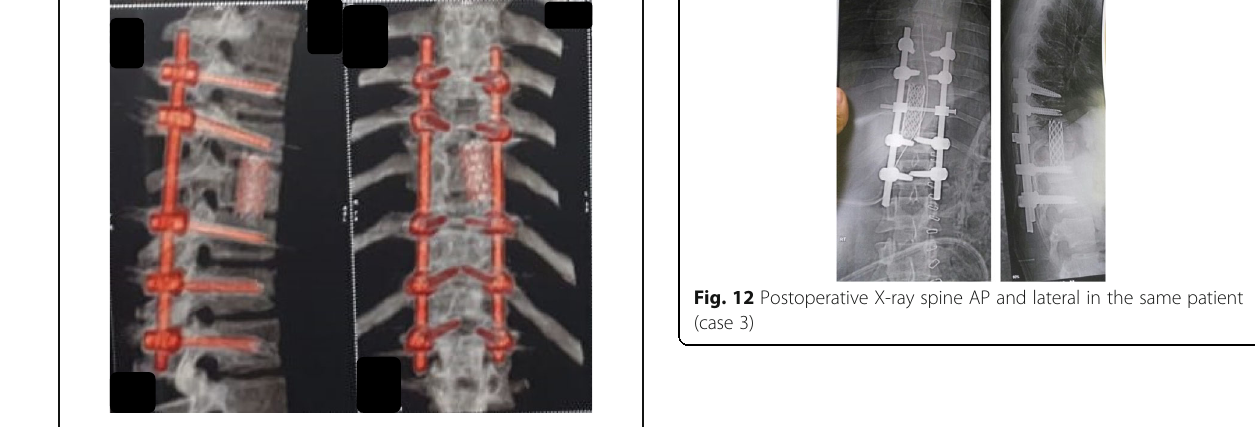
Fig. 10 Three months follow-up of CT of the spine showing the transpedicular screws and the pyramesh (case 2)